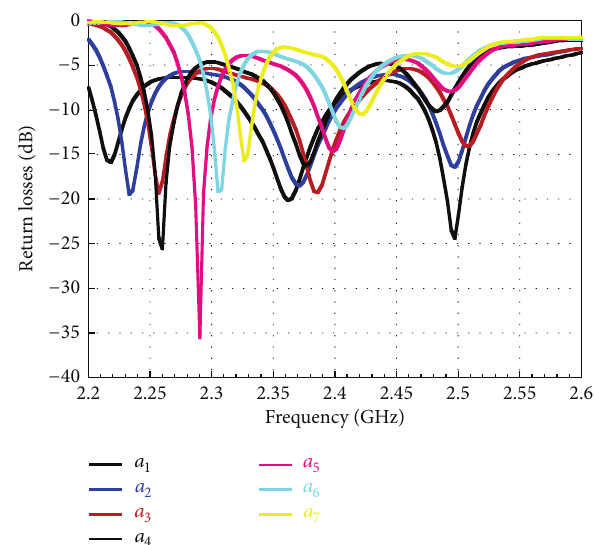
Figure 3: Return losses (50 Ω load line